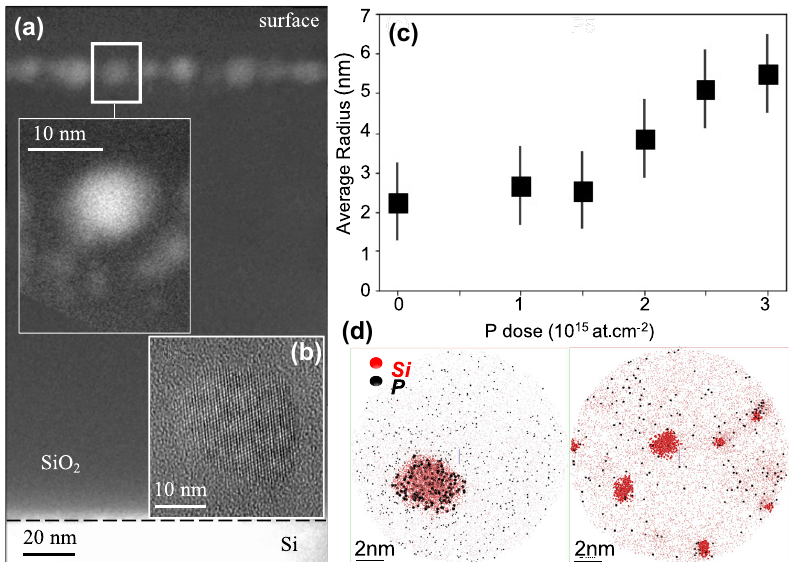
Figure 1: (a) EFTEM cross-sectional image displaying the spatial distribution of doped SiNCs for sample P5 (implanted at 3 × 10 15 at cm − 3 ), inset: zoom on the 20 nm thick implantation layer. (b) HREM image of a SiNC in the (110) zone axis. (c) Evolution of the size (big SiNCs) with implanted dose. (d) APT images of a large NC located at the projectedrangeoftheSiimplantationprofile (left panel) and of small NCs located in the profile tail (right panel). The red (black) dots are the Si (P) atoms, respectively.